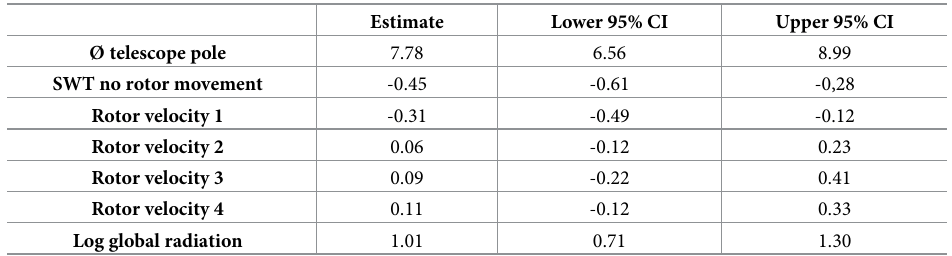
Table 1. Test statistics for Fig 3.